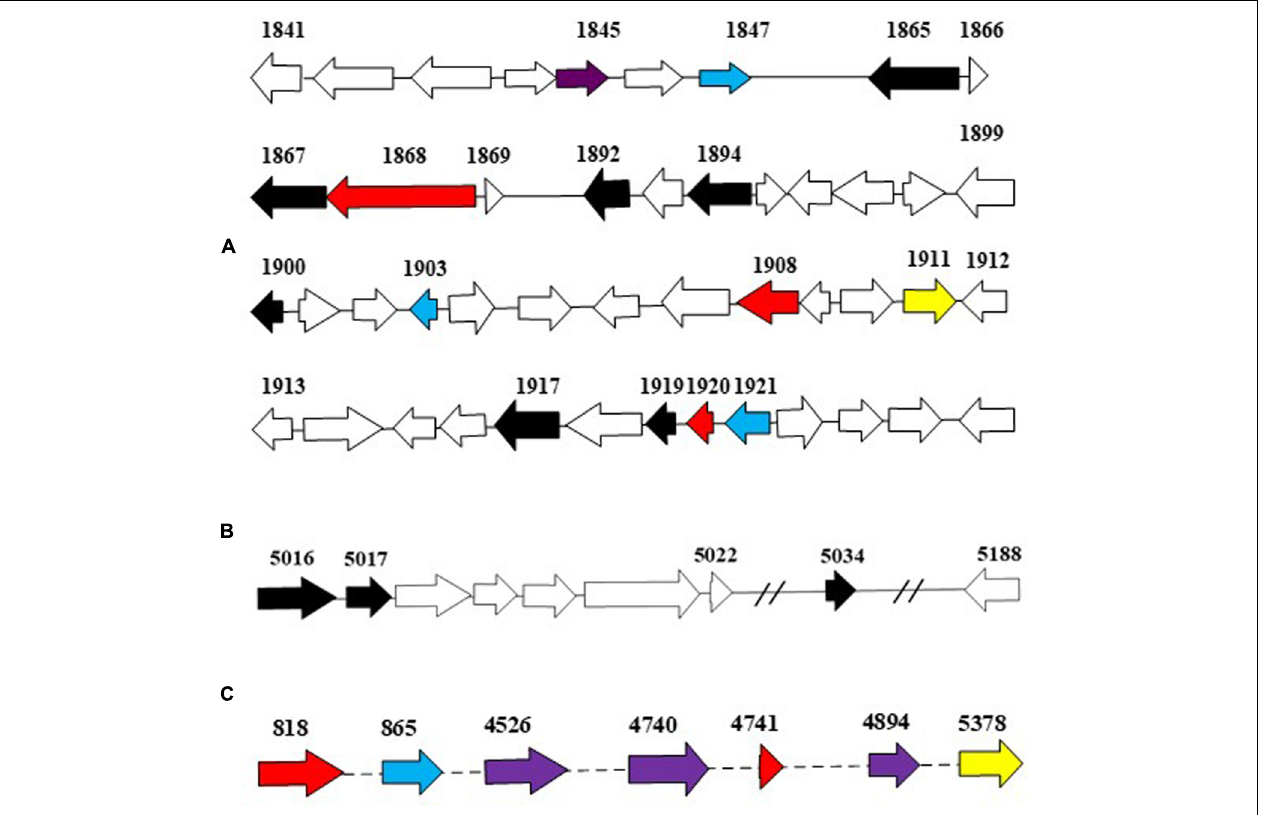
FIGURE 4 | The putative dioxygenase in PAH degradation. Genes in blue were induced by PYR as the sole carbon source; genes in yellow were induced by BbF as the sole carbon source; genes in red were induced by IcdP as the sole carbon source; genes in purple were induced by both IcdP and PYR as the sole carbon source, respectively; genes in black were induced by IcdP, PYR, and BbF as the sole carbon source, respectively. (A) , the A region for PAH degradation; (B) , the B region for PAH degradation; (C) , the dispersed genes in genome that probably involved in PAH degradation.